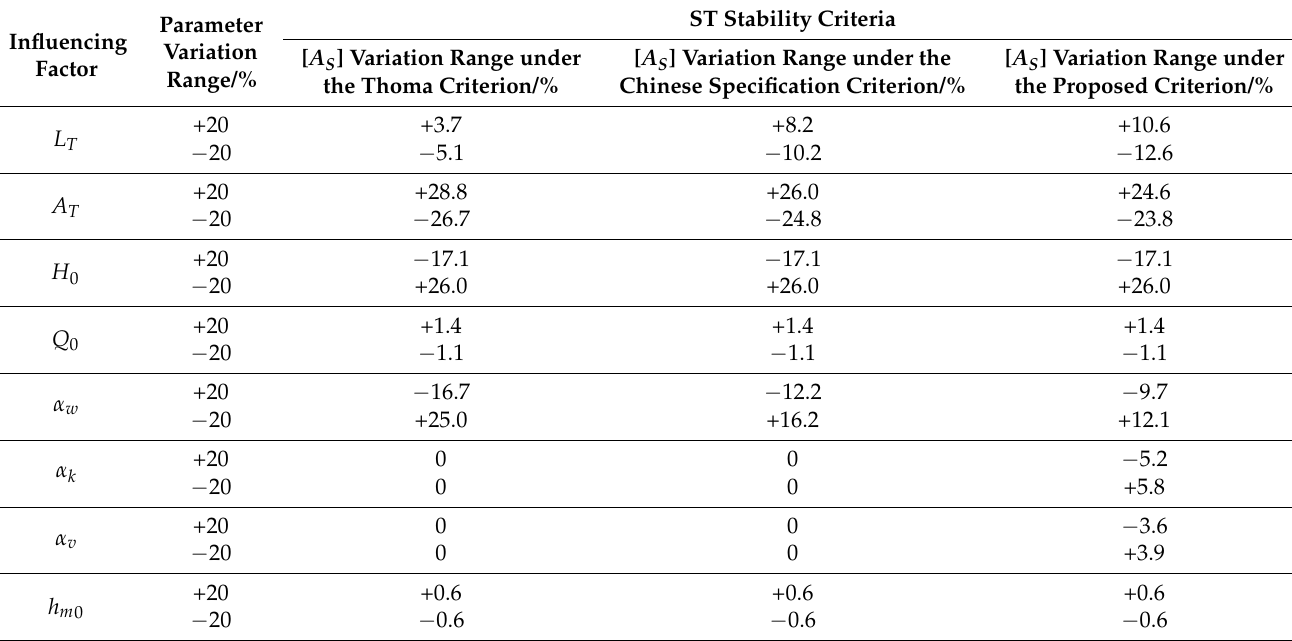
Figure 2. [ A S ] change process with respect to each influencing factor: ( a ) L T. ( b ) A T. ( c ) H 0 . ( d ) Q 0 . ( e ) α w. ( f ) α k. ( g ) α v. ( h ) h m 0 . Table 1. Sensitivity analysis results of the various influencing factors.